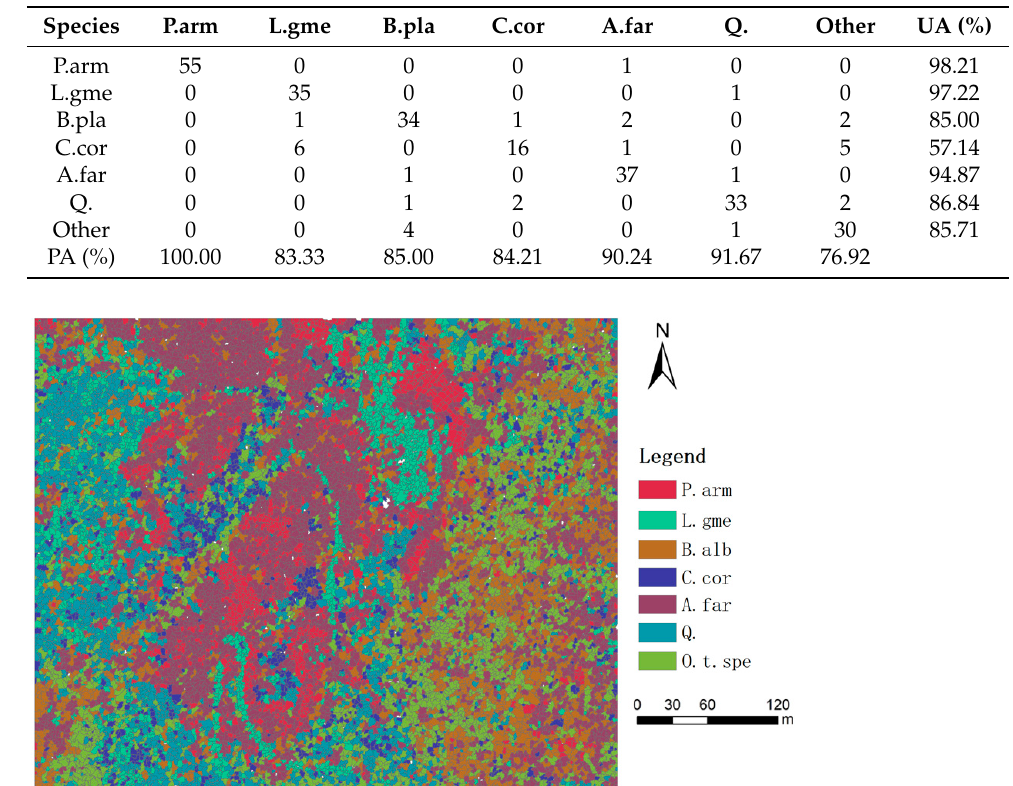
Figure 6. Classification results of tree species at altitude 1800 m based on XGBoost.